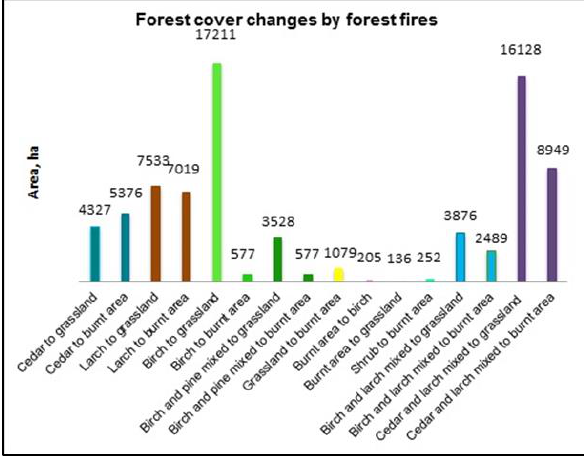
Figure 7. Forest cover and type change by forest fire